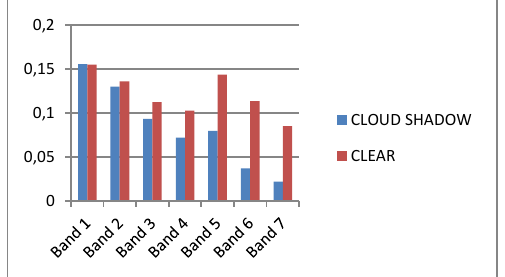
Figure 6. The difference of reflectance values between clear pixels and cloud shadow contaminated pixels on water